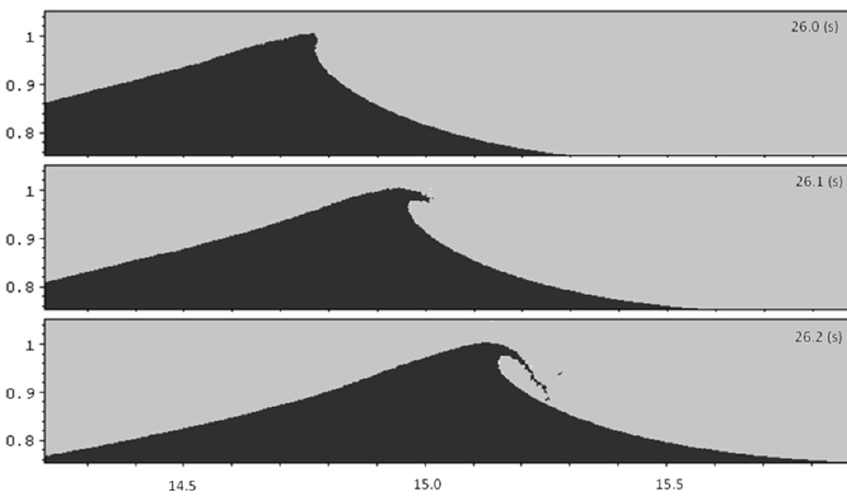
Fig. 8. The focused wave starts to break creating a plunger with a curling over plunging